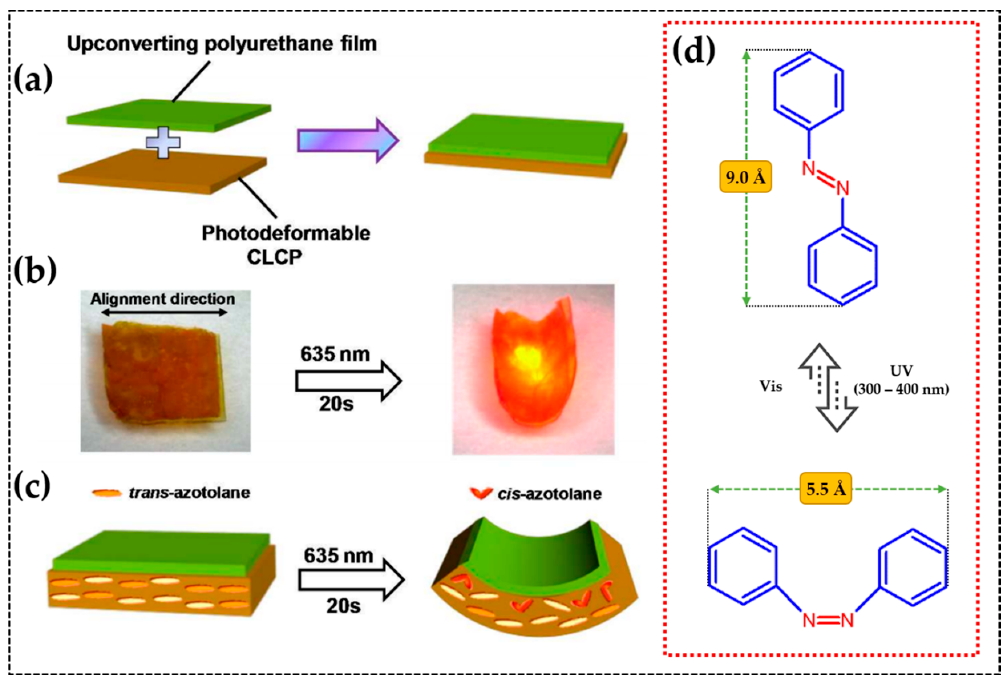
Figure 3. ( a ) Schematic illustration representing preparation of the assembly film composed of azotolane crosslinked liquid crystalline polymers (CLCP) film ( b ) Photographs of the as-prepared assembly film bending toward the light source along the alignment direction of the mesogens in response to the 635 nm laser with the power density of 200 mW cm -2 (Thickness of each layer in the assembly film: 15 µm of upconverting film and 27 µm of CLCP) ( c ) Schematic illustration demonstrating plausible mechanism for the photoinduced deformation of the as-prepared assembly film, Adapted with permission from [50], ACS, 2013. ( d ) Trans–cis isomerization of azobenzene molecule.